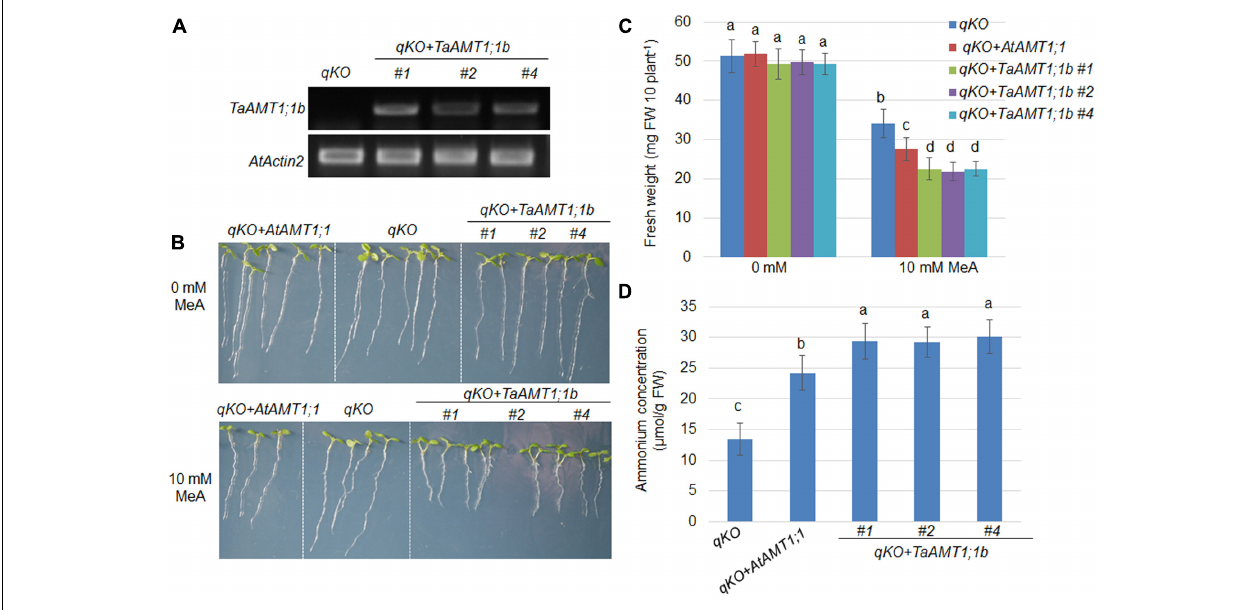
FIGURE 4 | Complementation of the Arabidopsis NH + 4 uptake defective mutant qko by TaAMT1;1b . TaATM1;1b was expressed in the qko background under the control of the AtAMT1;1 promoter. Expression levels of TaATM1;1b were monitored in the TaATM1;1b transgenic plant roots ( #1 , #2 , and #4 ), and AtActin2 was used as a loading control (A) . Methyl-ammonium (MeA) dependent growth of qko , qko+AtAMT1;1 , and qko+TaAMT1;1b was photographed. Three-day-old seedlings grown in 1 mM KNO 3 containing modified 0.5 × MS medium were transferred to the same medium containing either 0 or 10 mM MeA. Plant growth was photographed after 4 days (B) . Total fresh weight of the seedlings (30 seedling for each line) shown in (B) was measured. Significant differences between qko and qko+AtAMT1;1 or qko+TaAMT1;1b were assessed (C) . NH + 4 contents from the roots of 7-day-old qko , qko+AtAMT1;1 , and qko+TaAMT1;1b plants grown in 0.5 × MS medium were measured (D) . Significant differences at P < 0.05 level are indicated by different